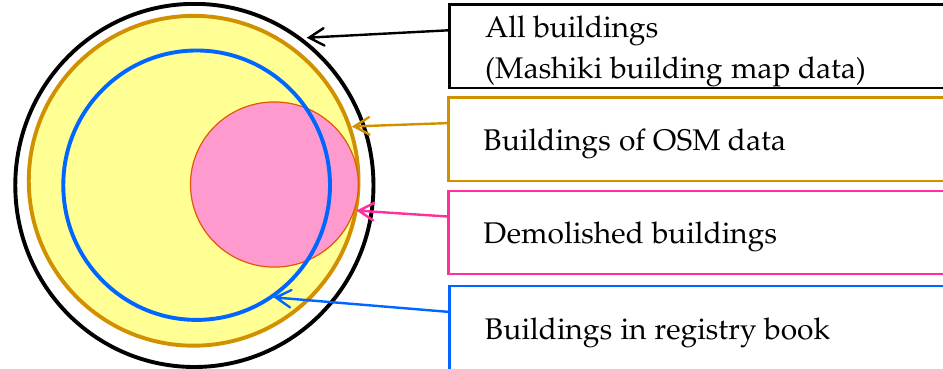
Figure 5. Euler diagram of coverage of all buildings, buildings of the OSM data, demolished buildings, and buildings in the registry book of Mashiki administration.